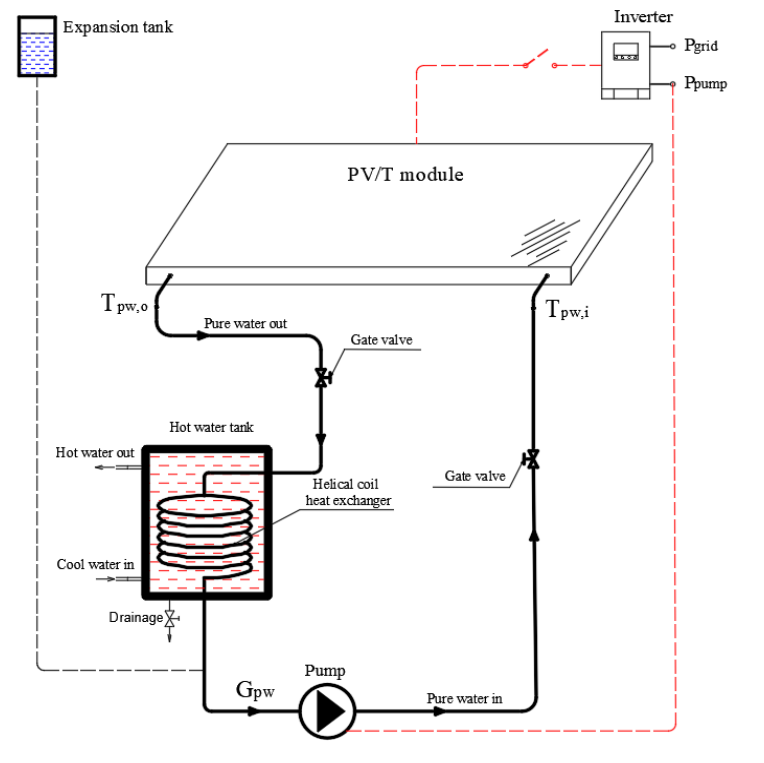
Figure 1. Water heating system using PV/T module.